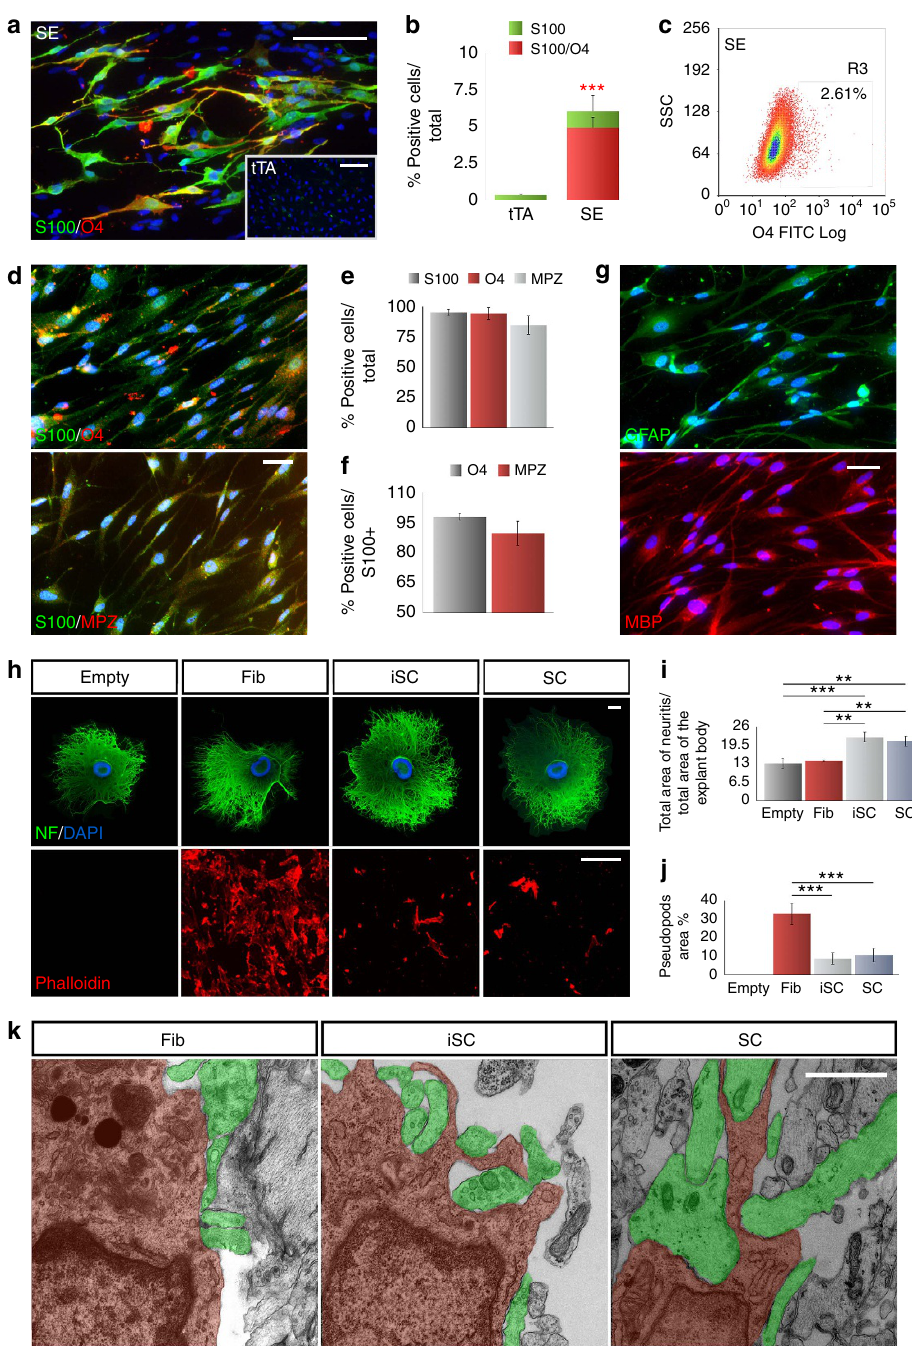
Figure 6 | Direct conversion of human skin fibroblasts into iSCs. ( a ) S100 (green) and O4 (red) immunofluorescence staining of Sox10/Egr2 (SE) or tTA-infected (inset) postnatal fibroblasts. ( b ) Quantification of S100 þ and S100 þ /O4 þ cells expressed as percentage over the total number of cells in experimental (SE) and control (tTA) conditions at 14 DIV (Mean ± s.d., n ¼ 4 independent experiments, 10 randomly selected 20 (cid:2) fields per sample were examined). ( c ) Fluorescence-activated cell sorting-based purification of the O4 þ iSC population. ( d ) S100/O4 and S100/MPZ immunofluorescence staining in iSCs. ( e , f ) Quantification of 14 DIV iSCs expressing S100, O4 and MPZ alone or in combination (Mean ± s.d., n ¼ 3 independent experiments, three coverslips/experiment/antigen, 10 randomly selected 20 (cid:2) fields per sample were examined). ( g ) Immunofluorescence for GFAP and MBP staining. ( h – j ) Pseudopod assay: sample images and quantification of DRG axonal growth ( h , top lane, and i ) and pseudopod formation ( h , bottom lane, and j )